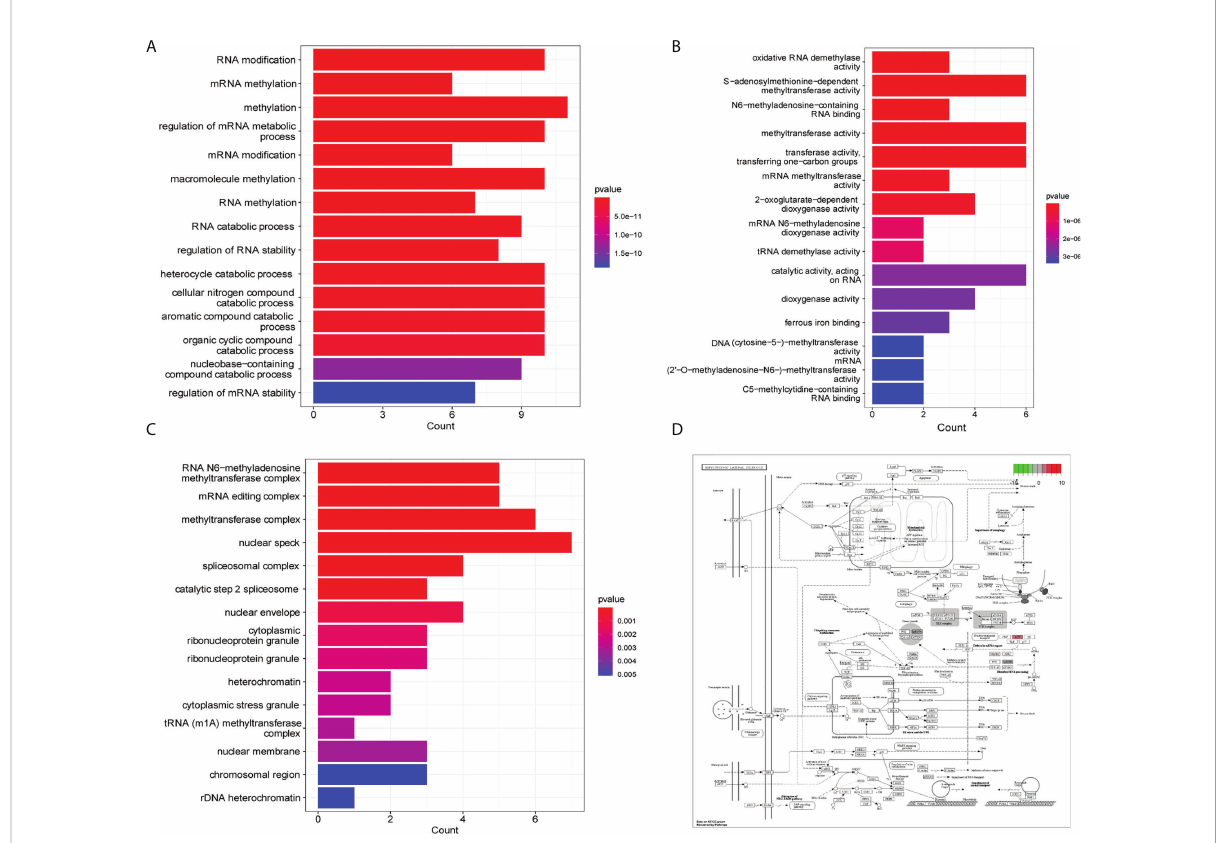
FIGURE 3 GO and KEGG enrichment analysis. (A) GO enrichment analysis histogram (biological process), the abscissa is the number of genes, the ordinate is GO term, and the color indicates padj. (B) Histogram of enrichment analysis (molecular function), the abscissa is gene number, the ordinate is GO term, and the color indicates padj. (C) Enrichment analysis histogram (cell components), the abscissa is the number of genes, the ordinate is the GO term, and the color indicates padj. (D) Path diagram of